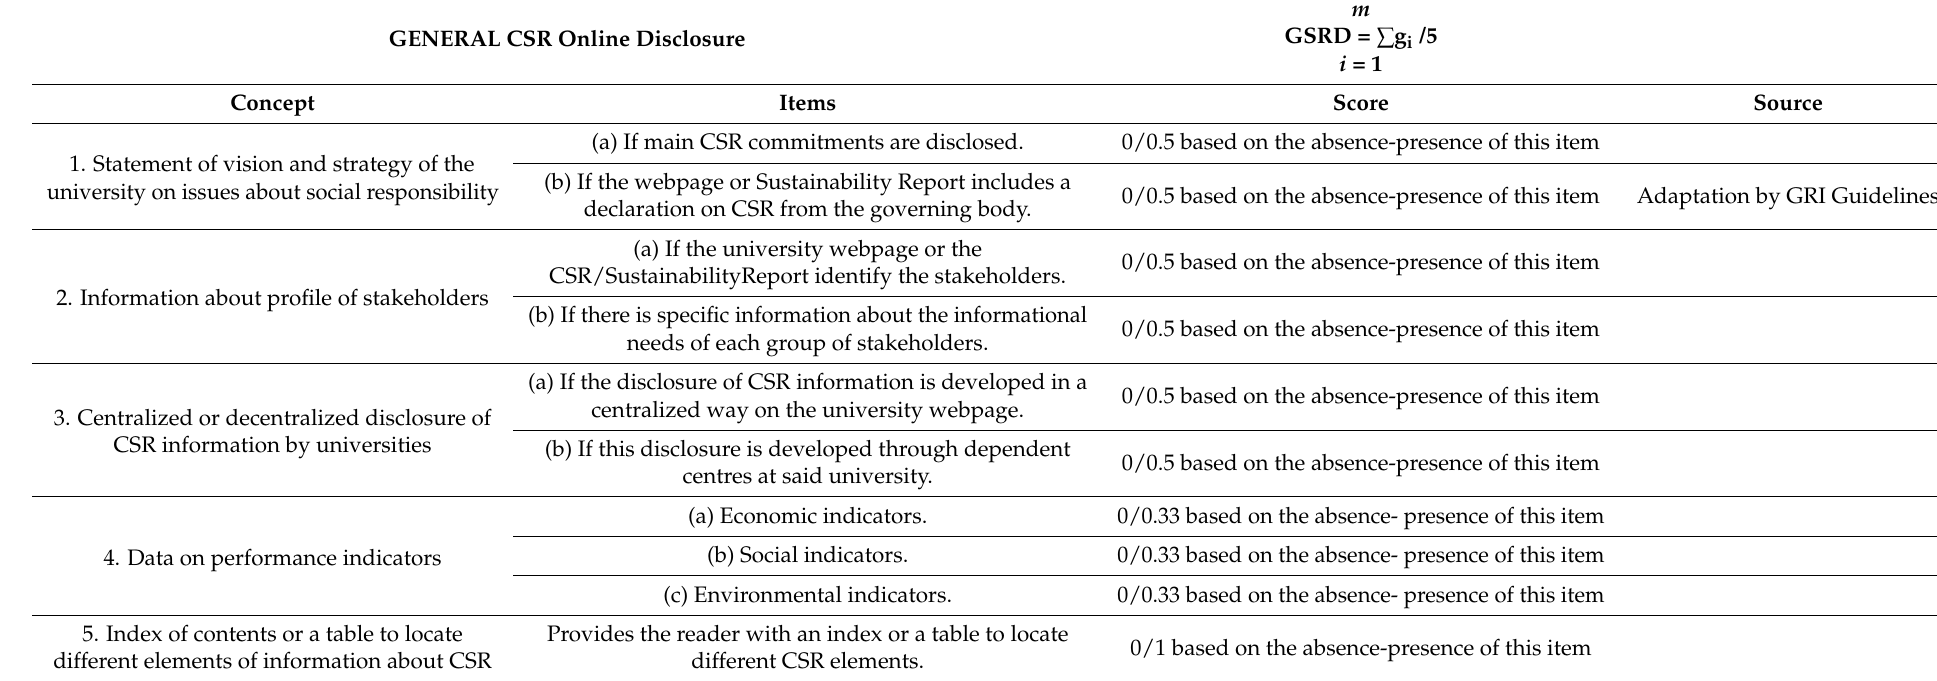
Table 2. Online disclosure of general CSR